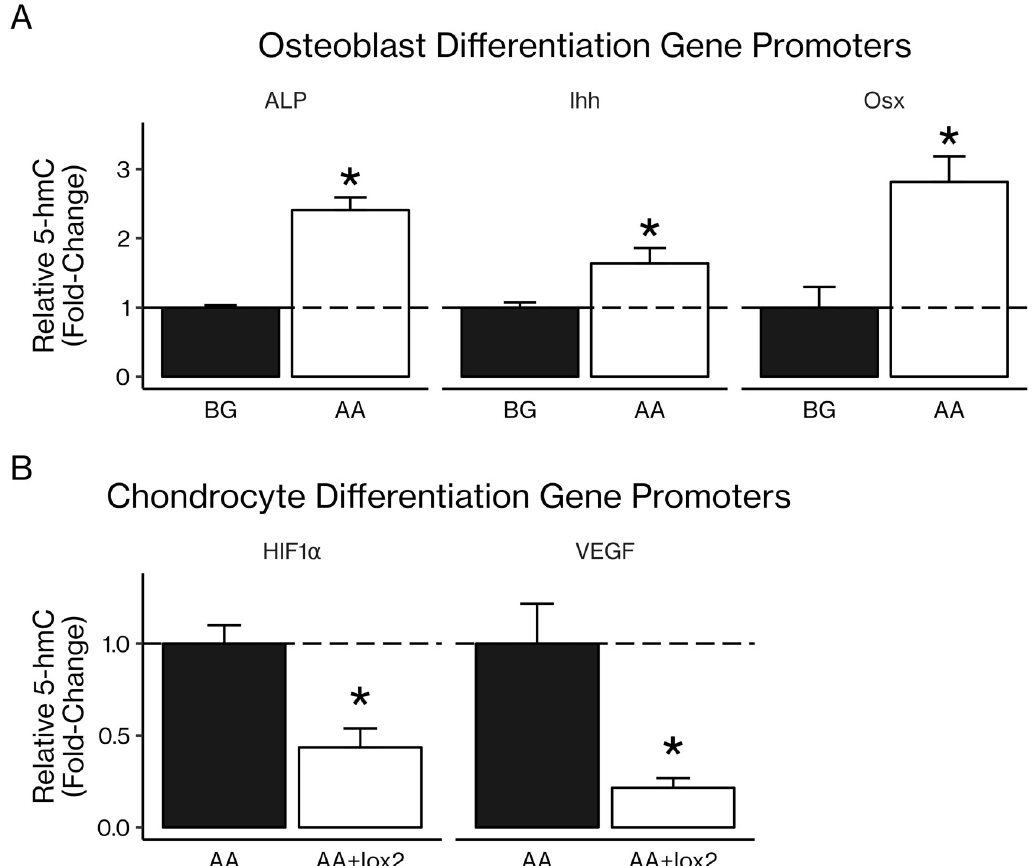
primary rib chondrocytes. An antibody specific for 5-hmC was used to pull down DNA rich in 5-hmC, and real-time PCR with primers for CpG-rich areas of osteoblast and chondrocyte gene promoters was used to determine the 5-hmC content of those promoters as an indirect measure of their demethylation status. (A) AA treatment significantly increased 5-hmC levels in the promoters of osteoblast differentiation genes alkaline phosphatase (ALP), Indian hedgehog (Ihh), and osterix (Osx). (B) Inhibition of PHD2 with Iox2 significantly decreased 5-hmC levels in the promoters of chondrocyte genes HIF1 α and VEGF. Results are presented as mean fold-change ± SEM. � P < 0.05 (Student’s t -test), n = 3 per